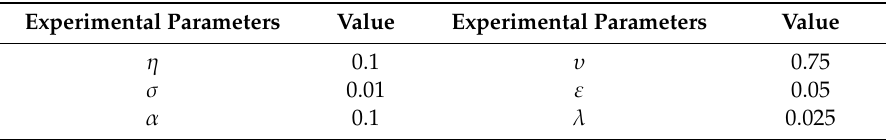
Table 1. Threshold parameters.